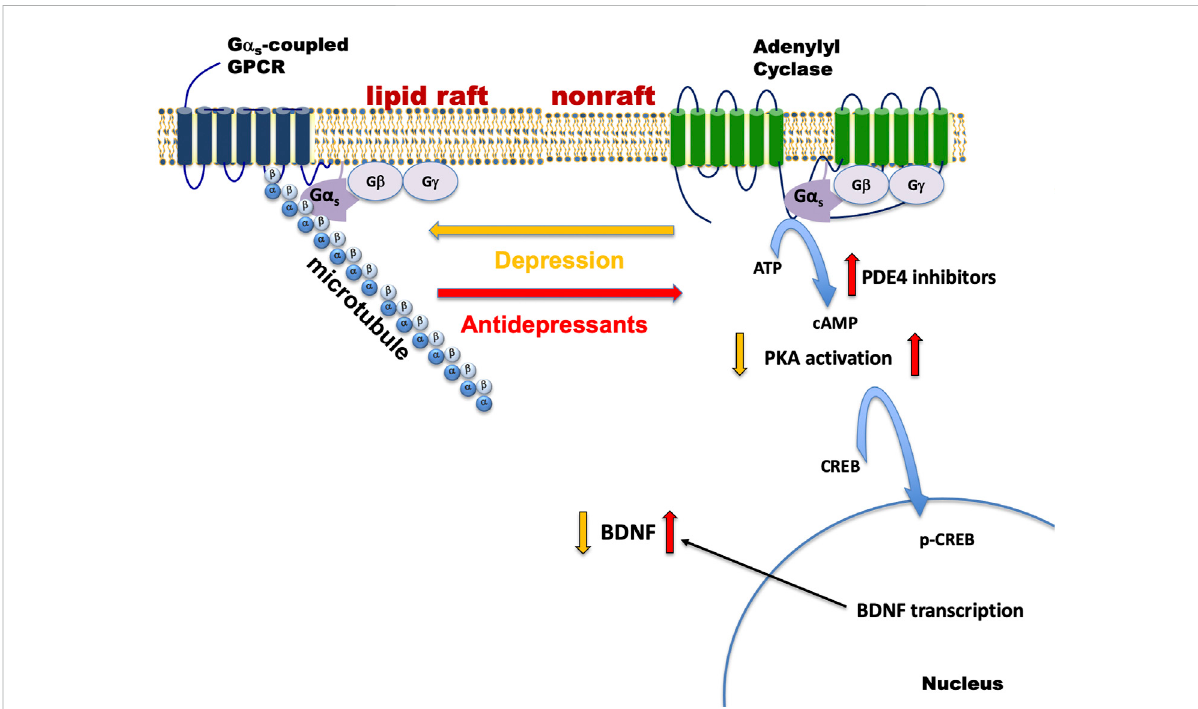
FIGURE 1 Depression and antidepressant effects on G α s plasma membrane localization. G α s is normally distributed between non-raft regions of the membrane where it moves freely and promotes neurotransmitter-activated adenylyl cyclase activity and a specialized region of the membrane rich incholesterol(lipidraft),wherethemovement/adenylylcyclaseactivationofG α s isimpaired.Duringdepression,G α s isenrichedinthelipidraftregion and it is anchored there by the structural protein, tubulin ( α / β ). Antidepressant treatment changes G α s such that it exits from the raft and moves to the non-raft region where it completes the process of neurotransmitter action by activating the enzyme, adenylyl cyclase. Increased G α s - mediated adenylyl cyclase activity results in increased generation of cAMP, PKA activation, phosphorylation of CREB, and increases in BDNF transcription and translation. cAMP phosphodiesterase (e.g., PDE4) is another point of regulation for cAMP and inhibition here will also result in increased cAMP activity. G α s -coupled GPCRs that may be relevant to depression include receptors for corticotropin releasing factor (CRF 1&2), serotonin (5-HT4,6,7), dopamine (D1), and β -adrenergic receptors. Antidepressant treatment also causes some G α s to be released from the plasma membrane, where it associates with microtubules and modi fi es their dynamic